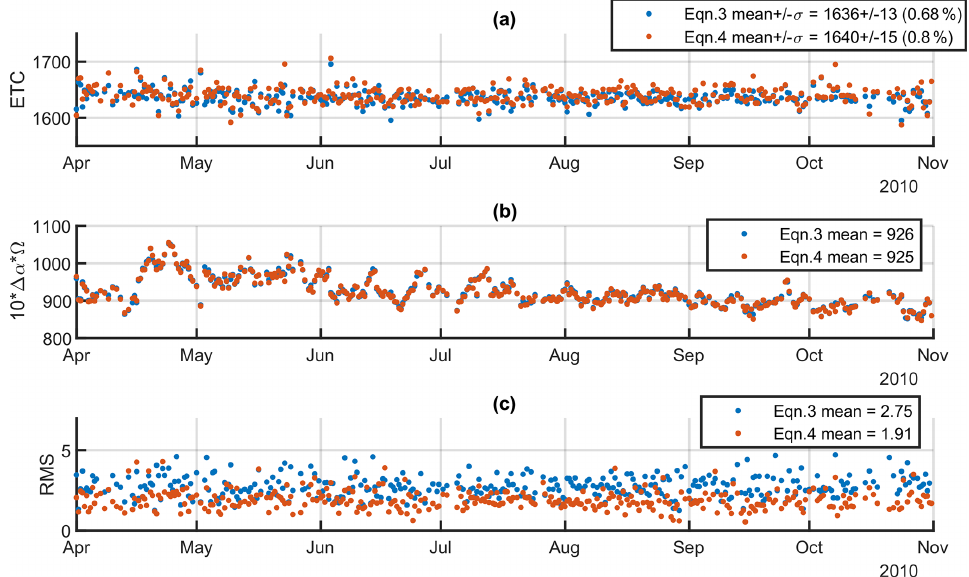
Figure 1. Brewer #119 individual ETC fitting results from April–October 2010 at MLO, (a) individual ETC values, (b) the intercept term of Langley fits (for Eqs. 4 and 5), (c) Langley fitting residual RMS. Each dot represents the results of one half-day estimate. The percentage value in the legend of panel (a) is the 1 σ value corresponding percentage (%) of TCO changes, in typical conditions ( (cid:127) = 280DU, (cid:49)α = 0 . 34, and µ =